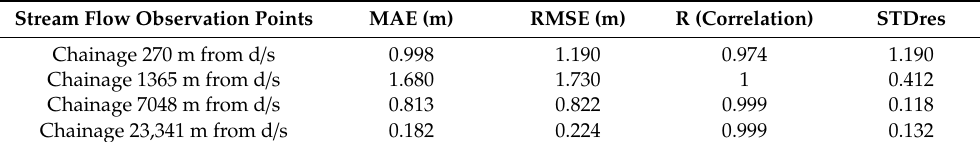
Table 7. Statistics of the objective function for river flow calibration.